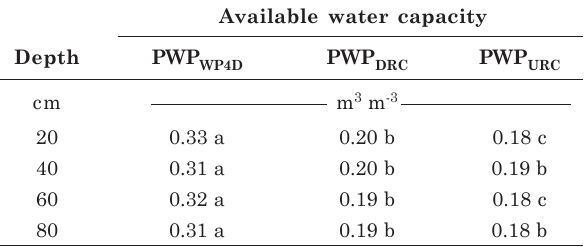
Table 7. Influence of the permanent wilting point (PWP) estimation method on the calculation of the available water capacity for plants in Red Latossol